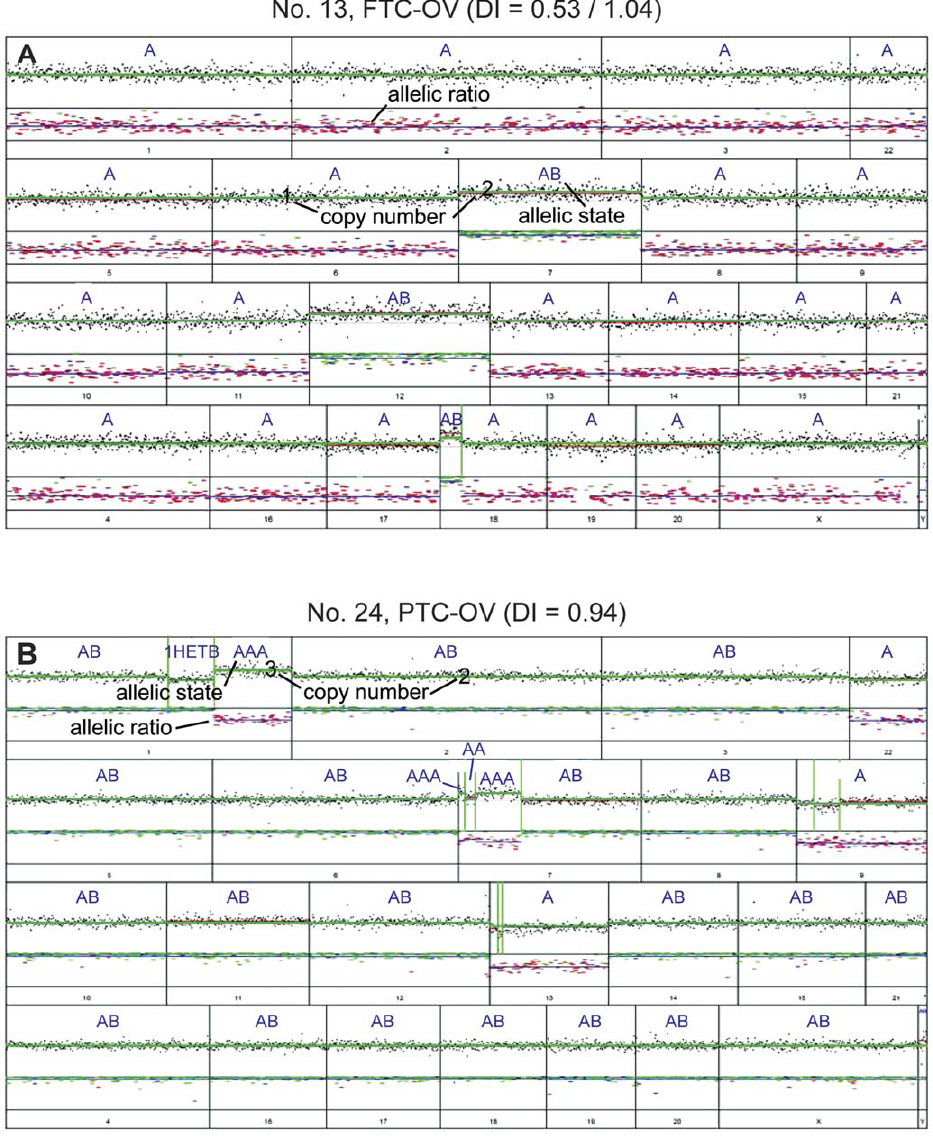
Figure 2. Examples of genome-wide allelic state analysis of an FTC-OV and a PTC-OV. A . FTC-OV (case No. 13, see also Figure 1) with DIs of 0.53 and 1.04 shows allelic state [A] for most chromosomes, except for chromosomes 7 and 12 and a segment of chromosome 18 showing retention (allelic state [AB]). Chromosome X also shows an allelic state [A]. B . The PTC-OV sample with a DI of 0.94 (case No. 24) shows a relatively limited number of genomic alterations. Chromosomes 1q and 7p showed an [AAA] allelic state after LAIR analysis. Another segment of 1q showed 1 copy but was heterozygous, which can be explained by a balanced mixture of two populations, one with an allelic state [A] and one with an allelic state [B], representing intra-tumour heterogeneity. In comparison with normal cells, one copy of chromosome 9, 13 and 22 was lost, as shown by the allelic state [A]. Both X chromosomes were detected in this female patient [AB].